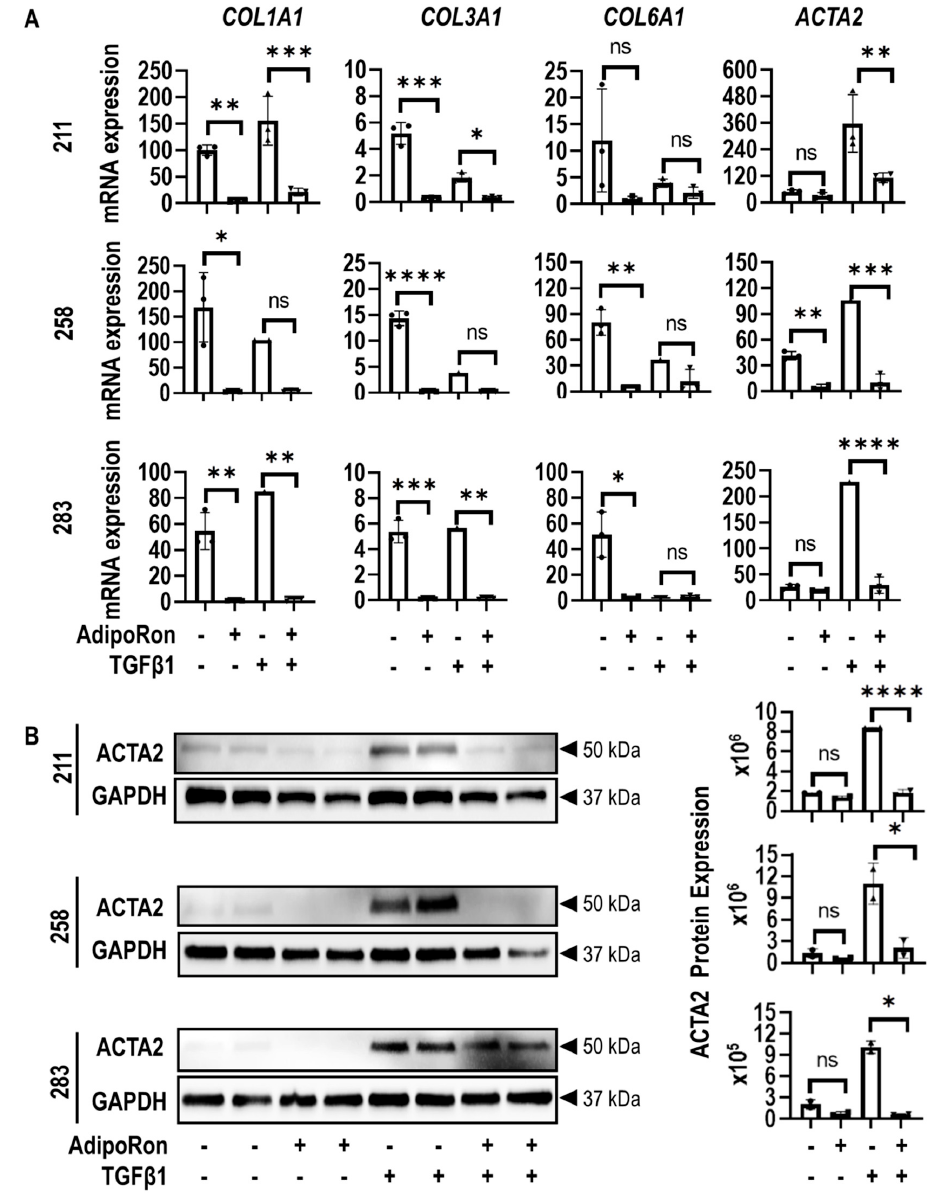
Figure 7. AdipoRon suppresses expression of fibrotic-related markers in MSCs. ( A ) Gene expression data obtained by RT-qPCR for fibrosis-related collagen genes COL1A1 , COL3A1 , COL6A1 , and ACTA2 ) in MSCs from three different MSC donors (211, 258, and 283) non-treated and treated with AdipoRon in the presence or absence of TGF β 1. ( B ) Western blotting of three MSCs donors non-treated and treated with AdipoRon in the presence or absence of TGF β 1. The data show that TGF β 1 induces ACTA2 levels and that AdipoRon inhibits this TGF β 1-dependent induction. Statistical difference in gene expression between groups is shown with brackets. Asterisks indicate differences in probability values: p ≤ 0.0001 = ****; p ≤ 0.001 = ***; p ≤ 0.01 = **; p ≤ 0.05 = *; p > 0.05 = not significant (ns). Statistical significance and error bars (mean ± standard deviation) are based on n = 3 biological replicates for each of the three MSC donors (data points superimposed on the graphs). Western blot quantitation shows results for n = 2 biological replicates for each of the three MSC donors. Error bars present the mean ± range of the two biological replicates (represented as 2 dots superimposed on the graph).